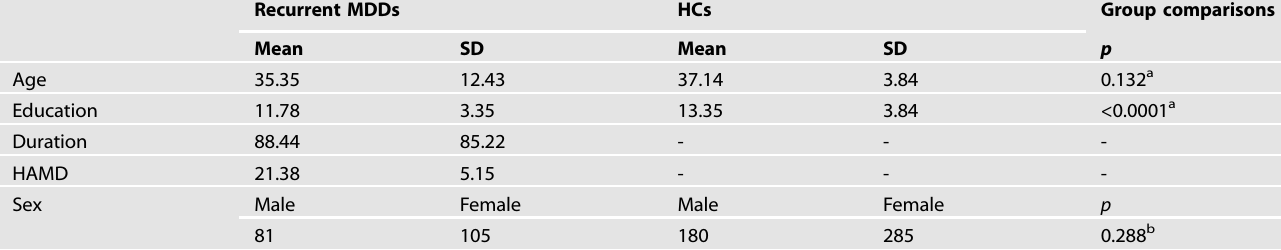
HAMD Hamilton rating scale for depression, HC healthy control, MDD major depressive disorder, SD standard deviation. a The p value was obtained by two-sample t -tests. b The p value was obtained by a chi-square test.